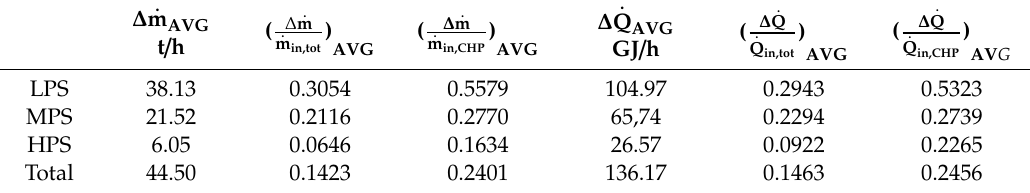
Table 7. Results of mass and heat balances of individual steam pressure level networks.